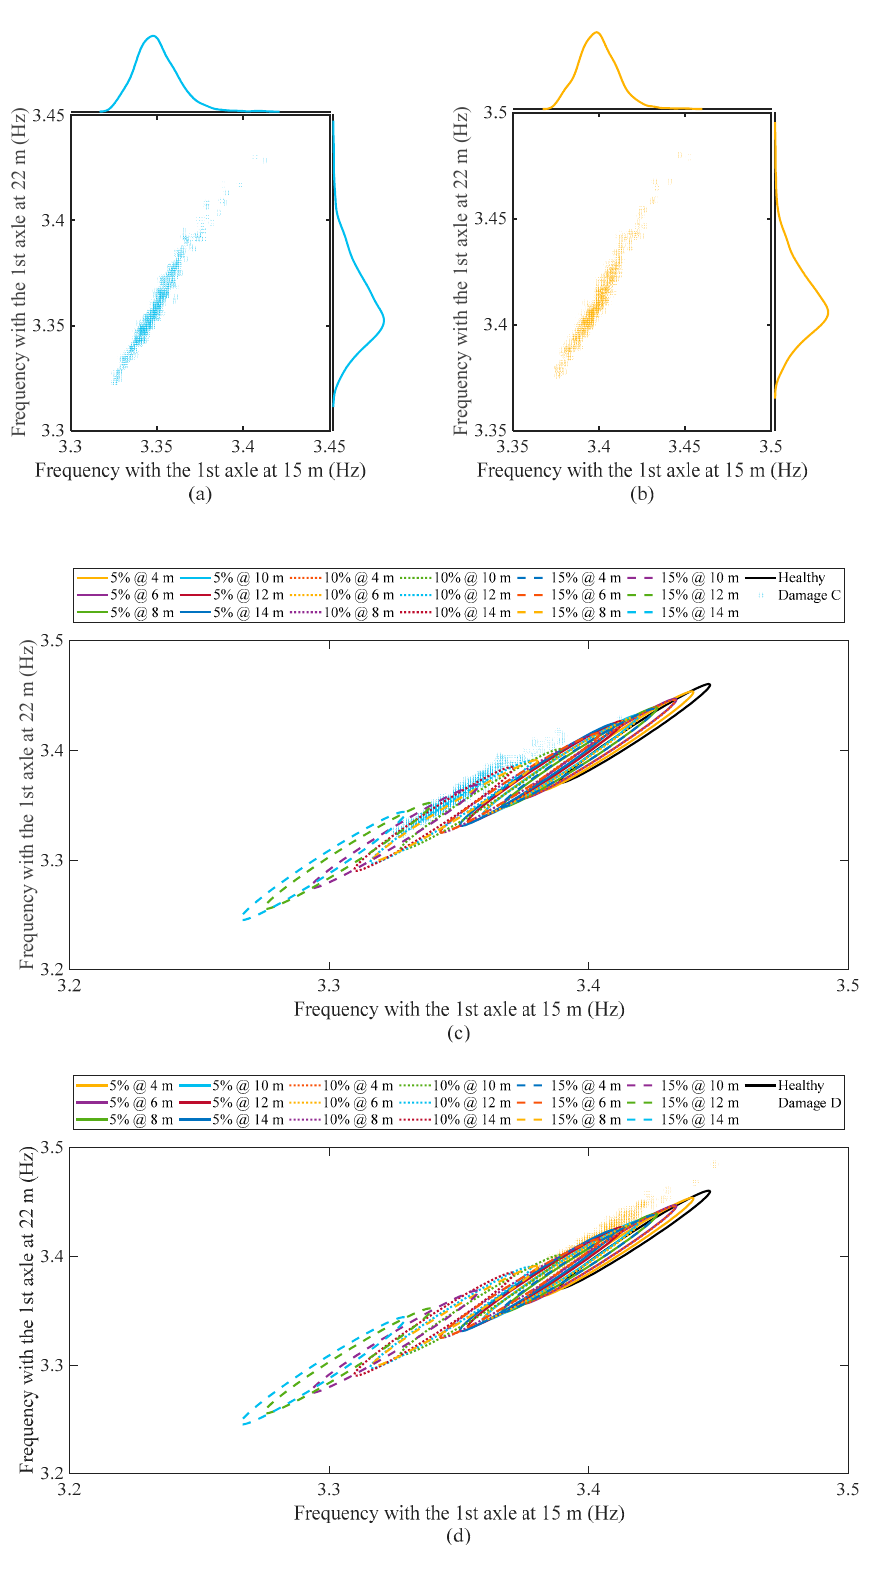
Figure 16. Comparison between transient forced frequencies ( 𝐹 (cid:2869)(cid:2873) , 𝐹 (cid:2870)(cid:2870) ) due to the crossing of 1000 trucks and eigenvalue database: ( a ) distributions of 𝐹 (cid:2869)(cid:2873) and 𝐹 (cid:2870)(cid:2870) for damage ‘C’, ( b ) distributions of 𝐹 (cid:2869)(cid:2873) and 𝐹 (cid:2870)(cid:2870) for damage ‘D’, ( c ) Damage ‘C’ against database, and ( d ) Damage ‘D’ against data- base.